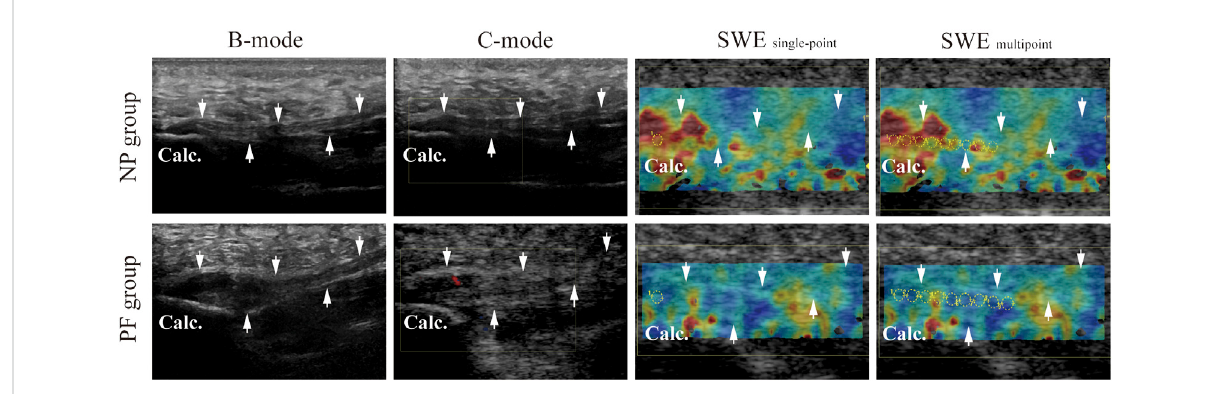
FIGURE 2 Acquisition plantar fascia images (arrows) of different ultrasound modalities in both NP group and PF group. Ultrasound modalities include B-mode, C-mode, and SWE. B-mode, and B-mode ultrasonography; C-mode, Color Doppler mode ultrasonography; SWE, shear wave elastography; NP group, non-pain group; PF group, plantar fasciopathy group; Calc,